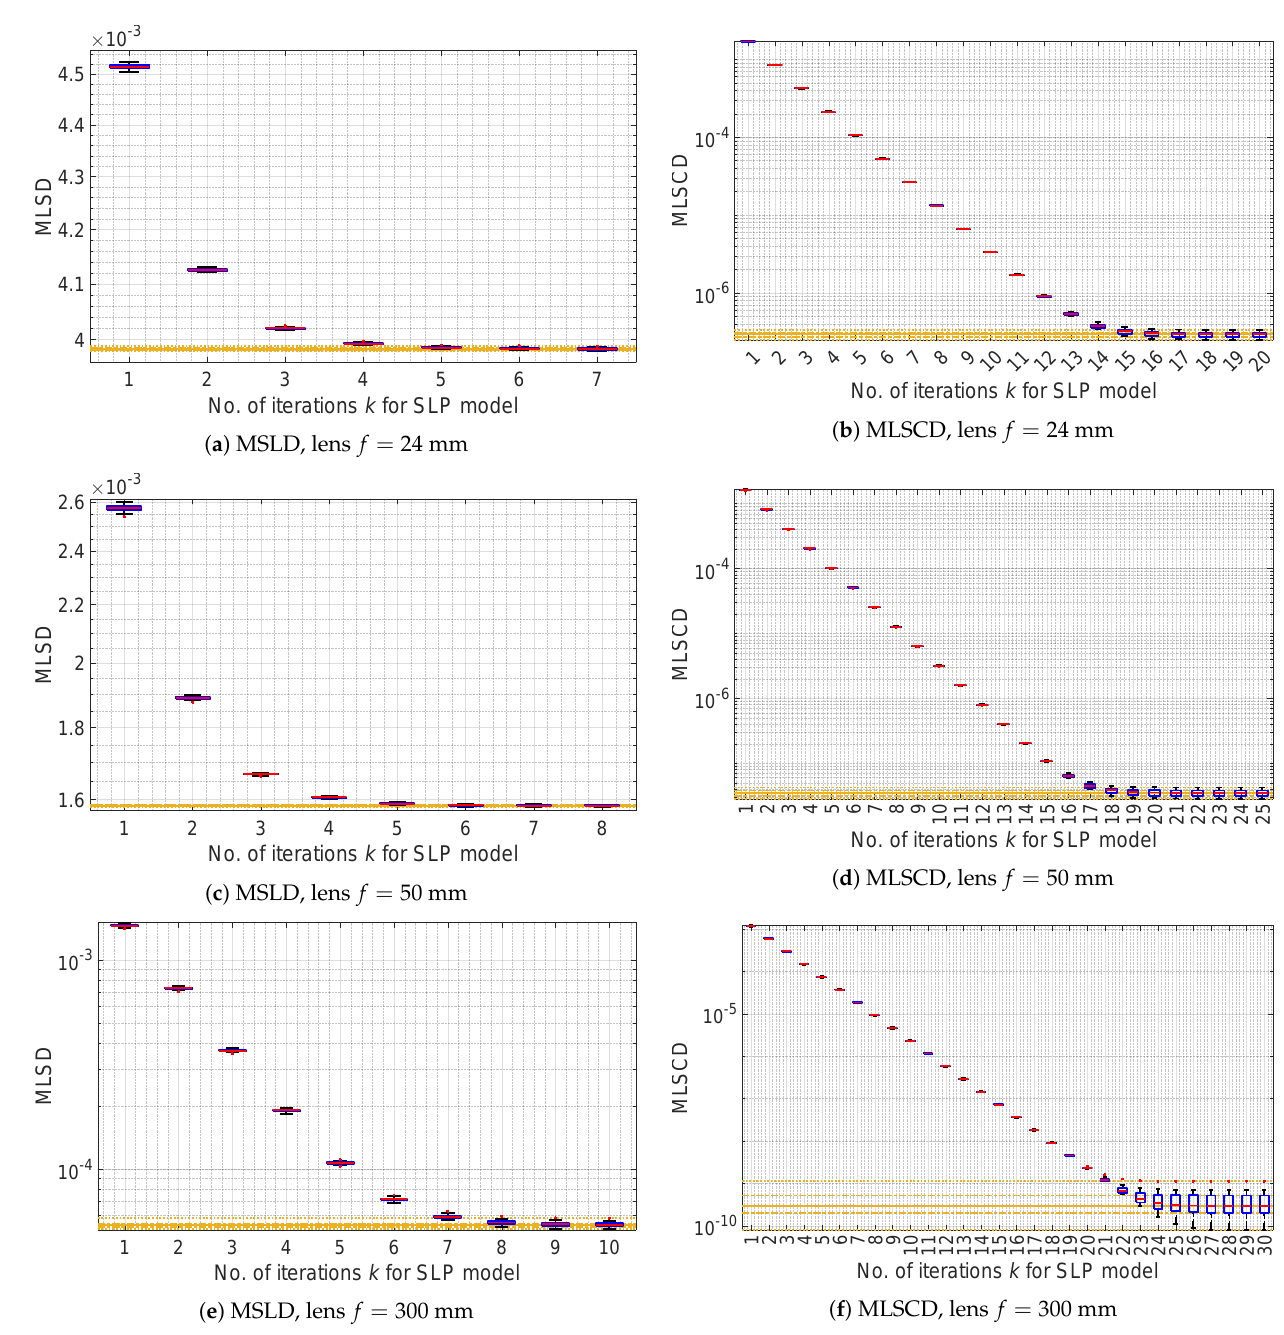
Figure 3. Comparison of MLSD and MLSCD values obtained for the LP, SLP, and SNILP models and simulated vignetting of lenses with different focal length f ; results for I V contained with Gaussian mixture noise (A5) for σ add = 5% and σ multi = 10%. Results for the LP model are equal to results from the SLP model for k = 1. Results for the SNILP model are presented as orange lines, whereas lines, from bottom to top, represent minimal, first quartile, median, third quartile, and maximal of error